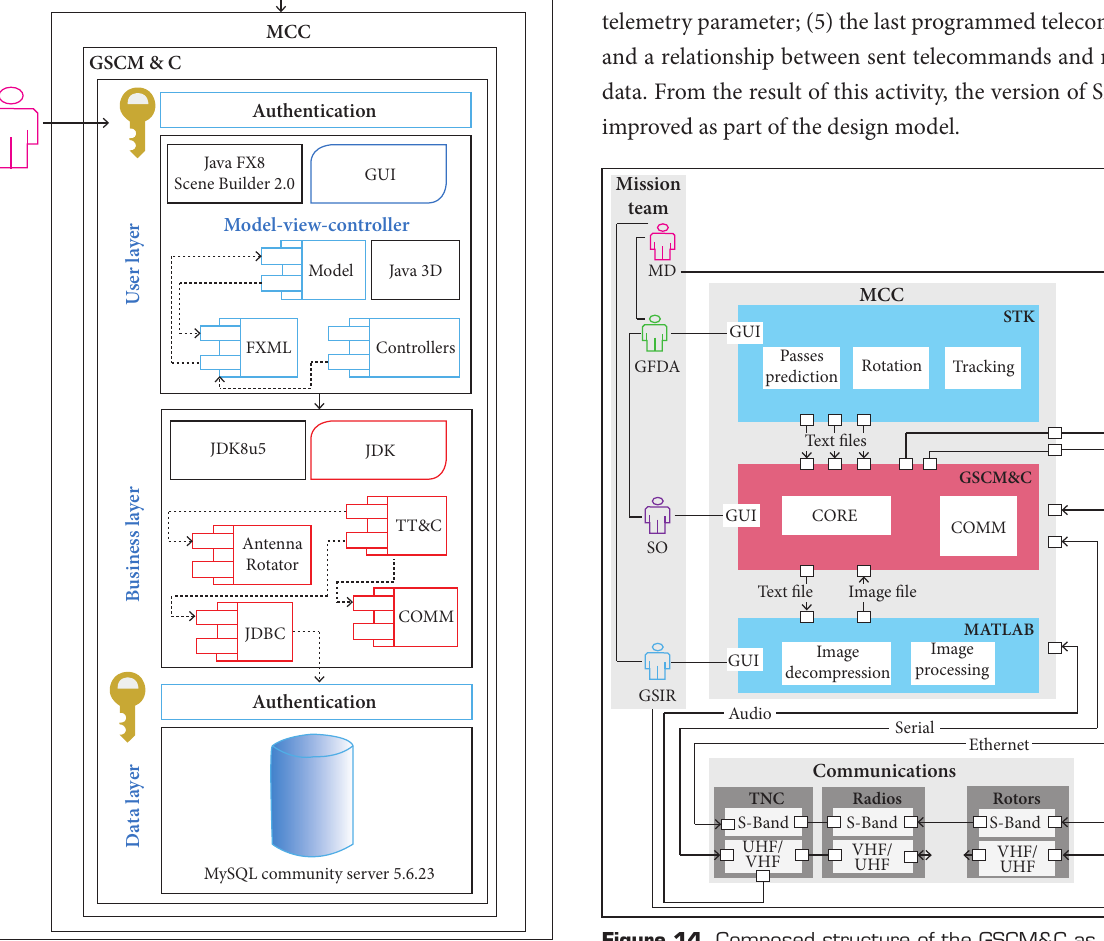
figure 13. GSCM&C architecture with respect to MCC.